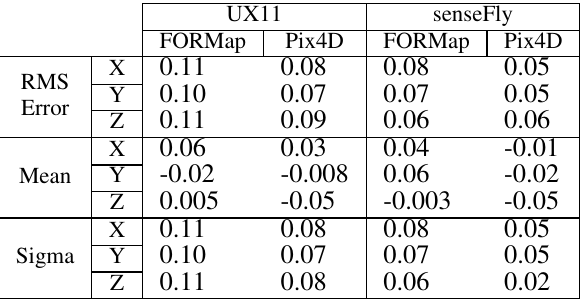
Figure 7. The 3D dense point cloud reconstructed by FORMap from 1976 images from the Ineres dataset. Flight path is presented in red dots.